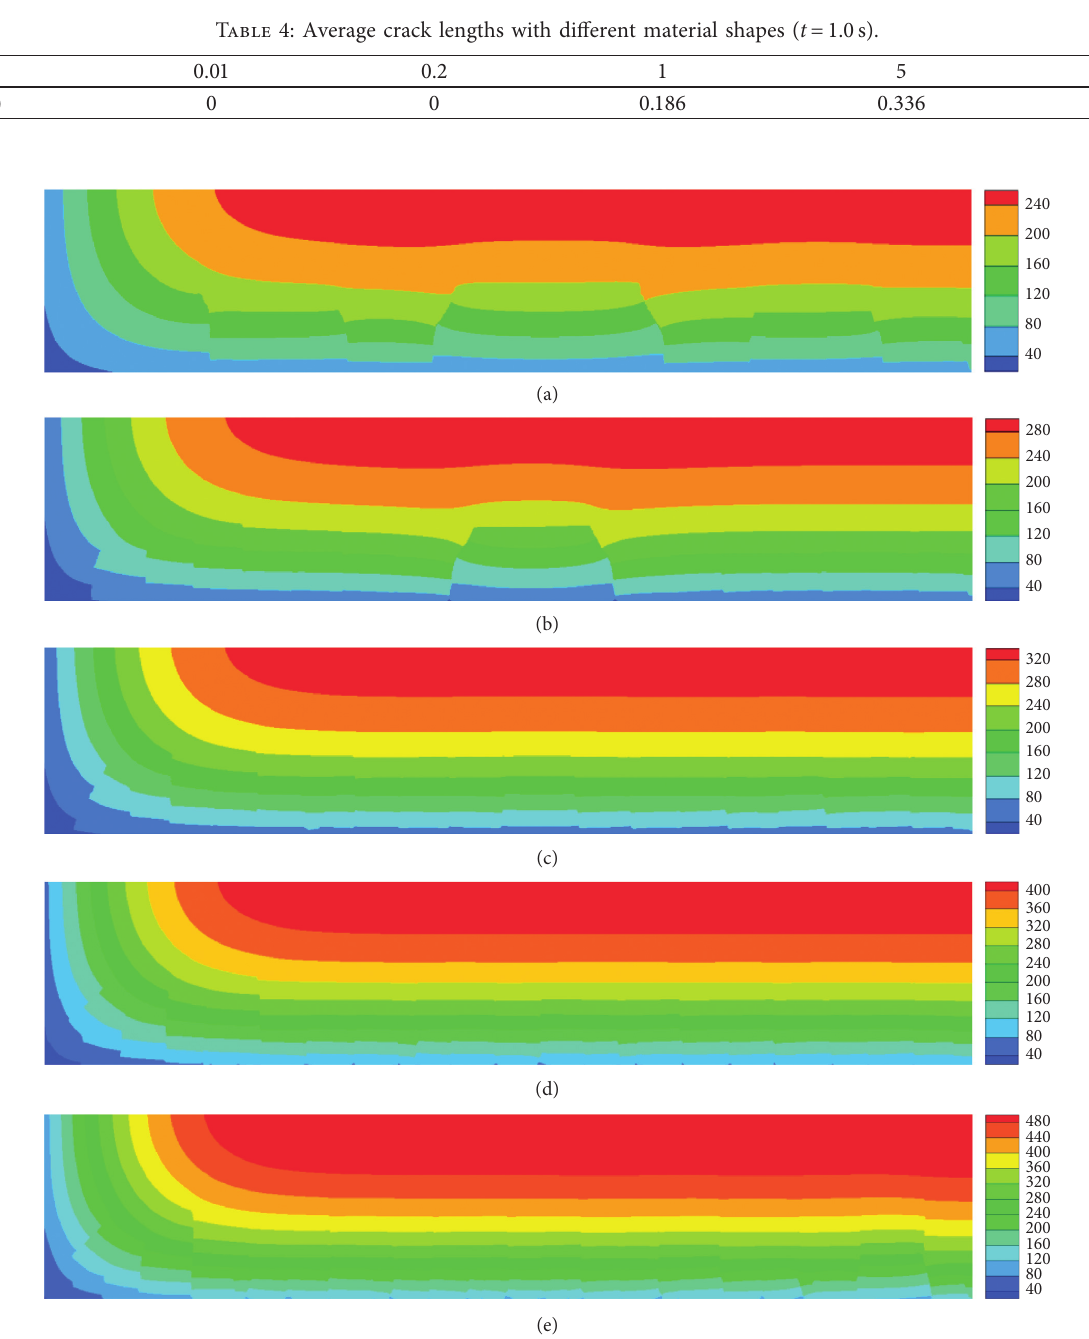
Figure 16: Temperature fields with different initial temperatures ( t � 1.0 s): (a) T (e) T 0 � 600 ° C.